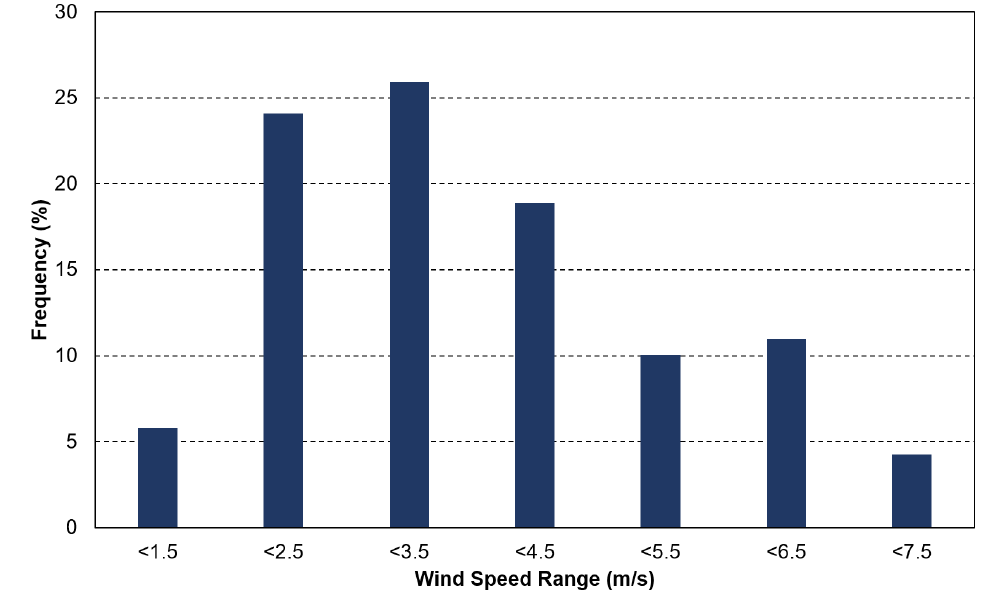
Figure 4. Wind speed